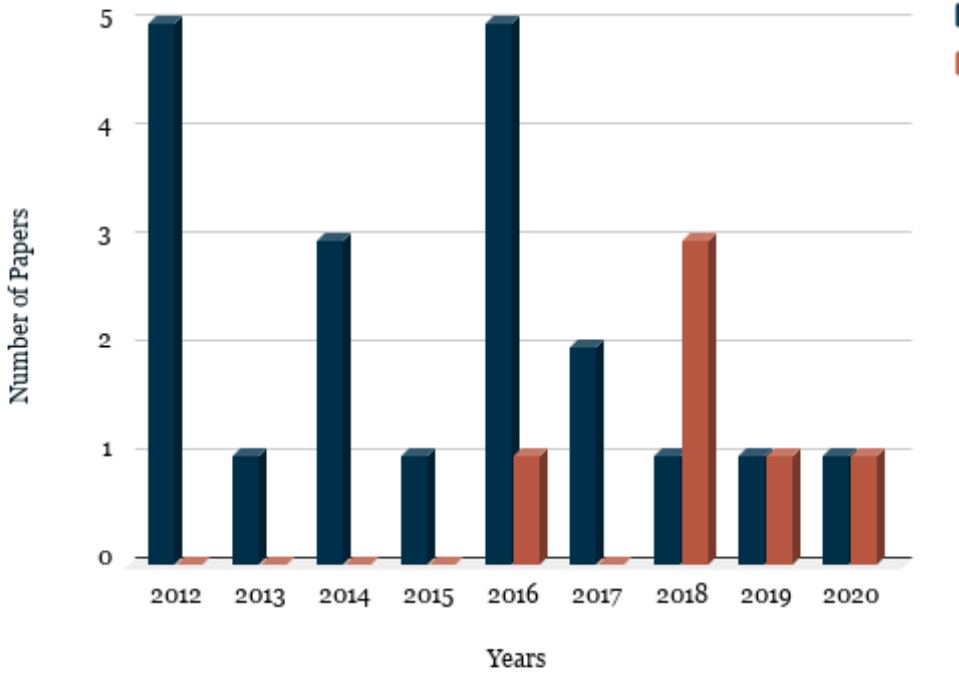
Figure 4. Number of papers by year of